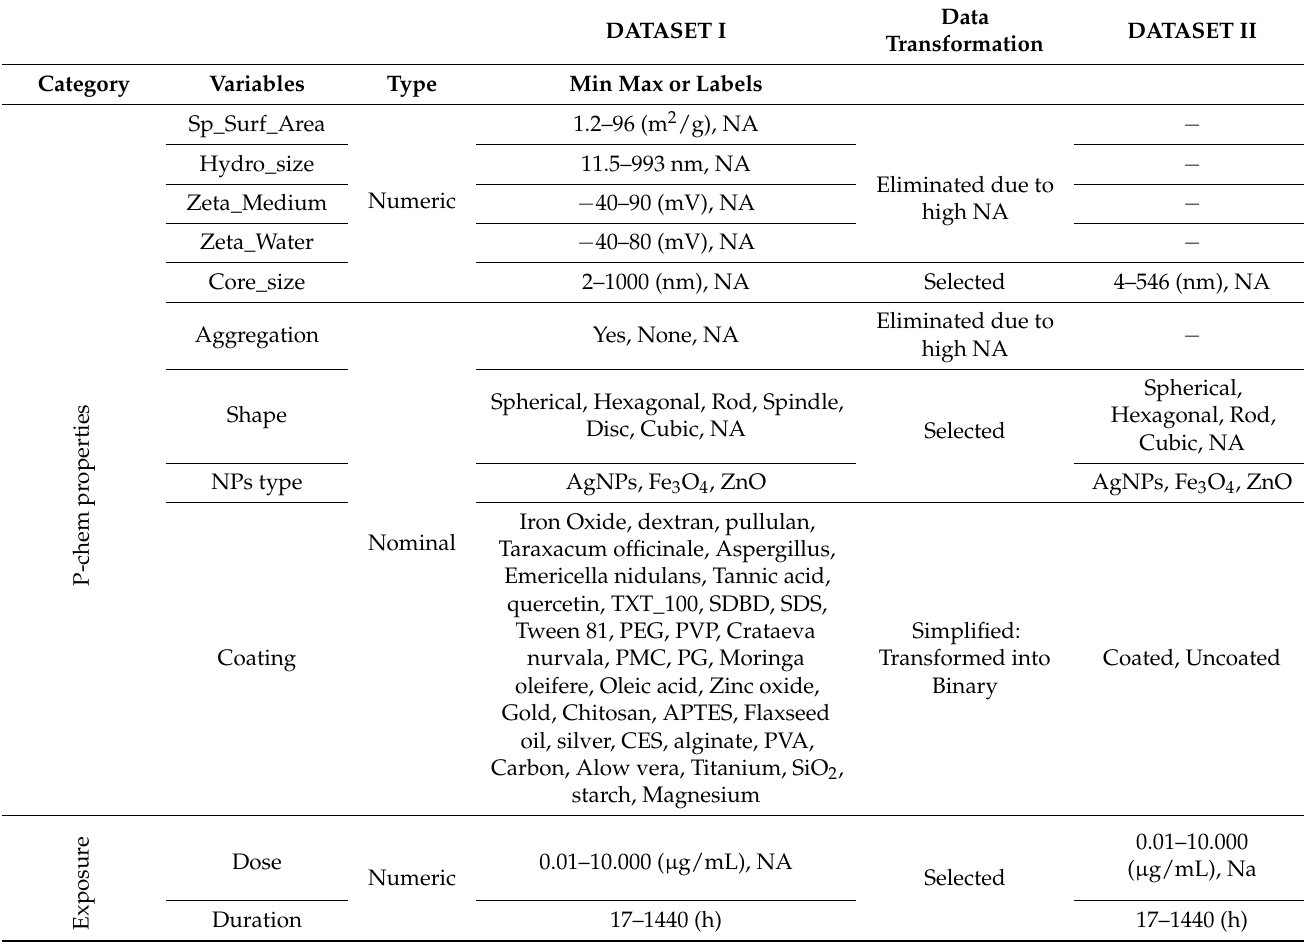
Table 1. The primary and final Input variables in Dataset I and Dataset